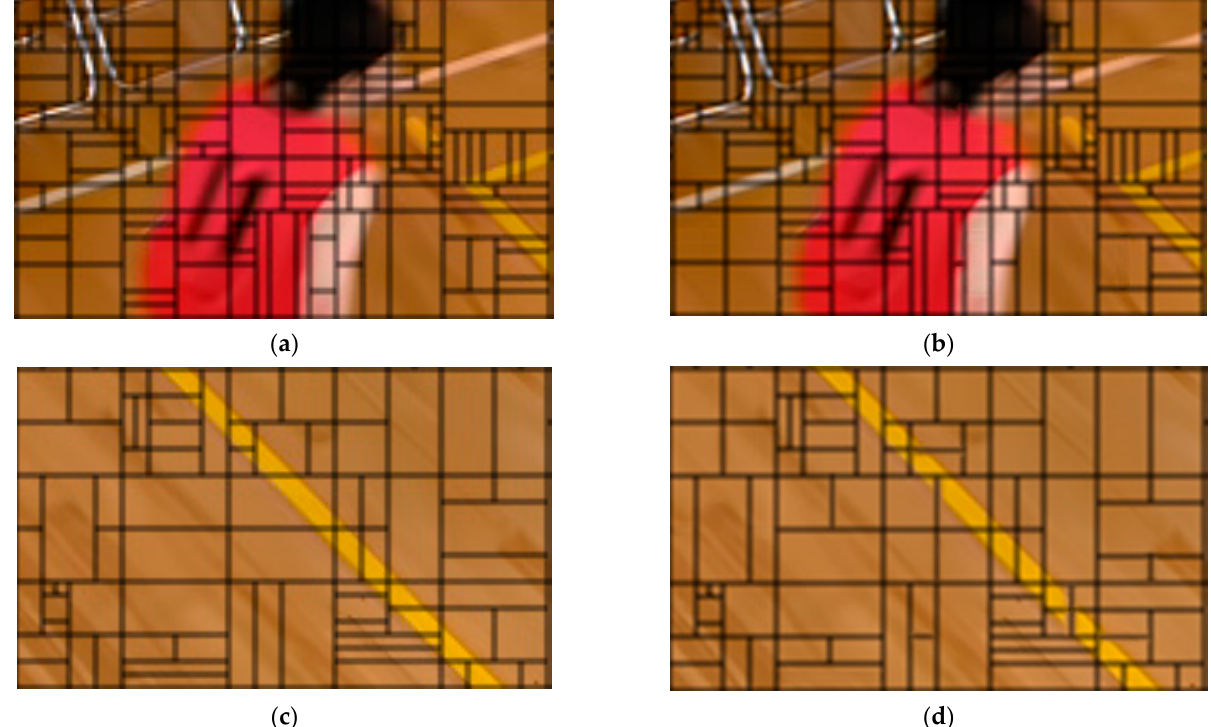
Figure 8. Chart of CU division results comparison: ( a ) CU partition map of complex texture area under VTM10.0 configuration; ( b ) CU partition map of complex texture area under the proposed algorithm; ( c ) CU partition map of smooth texture area under VTM10.0 configuration; and ( d ) CU partition map of complex texture area under the proposed algorithm.